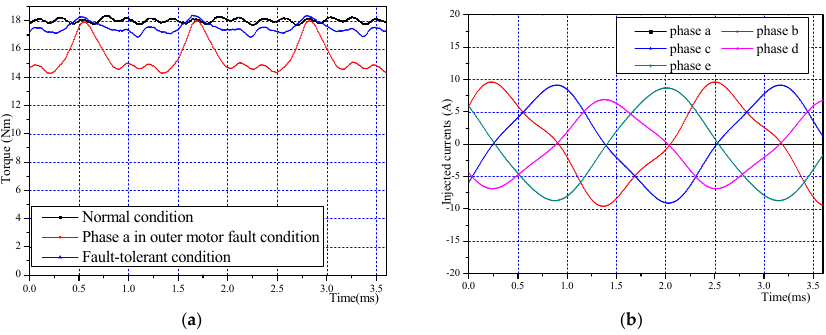
Figure 12. The motor operates under single ‐ phase open circuit in outer motor conditions: Figure 12. ( a ) electromagnetic torque obtained by FEA; ( b ) the injected fault ‐ tolerant currents of outer motor.